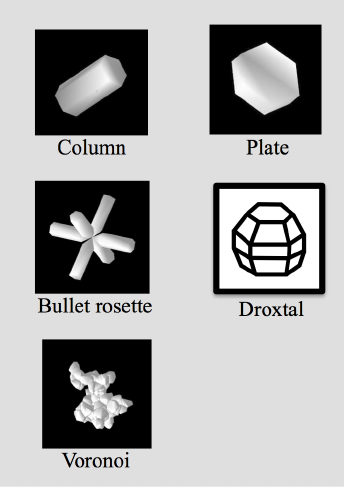
Figure 1. SGLI cloud particle